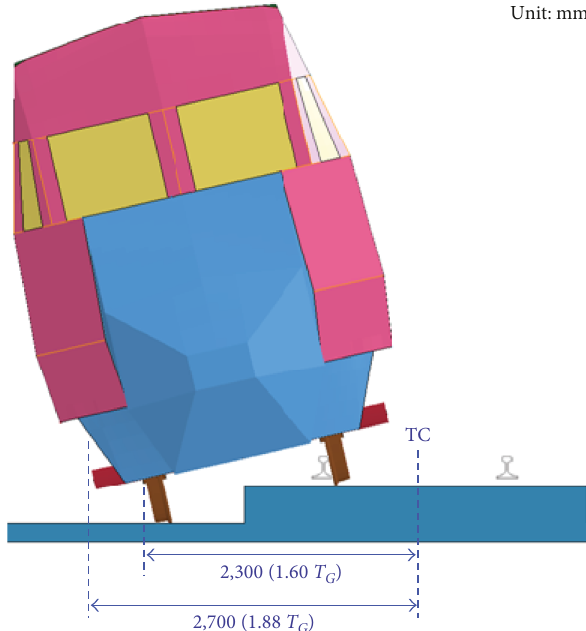
Figure 14: Overview of distance effect 4.